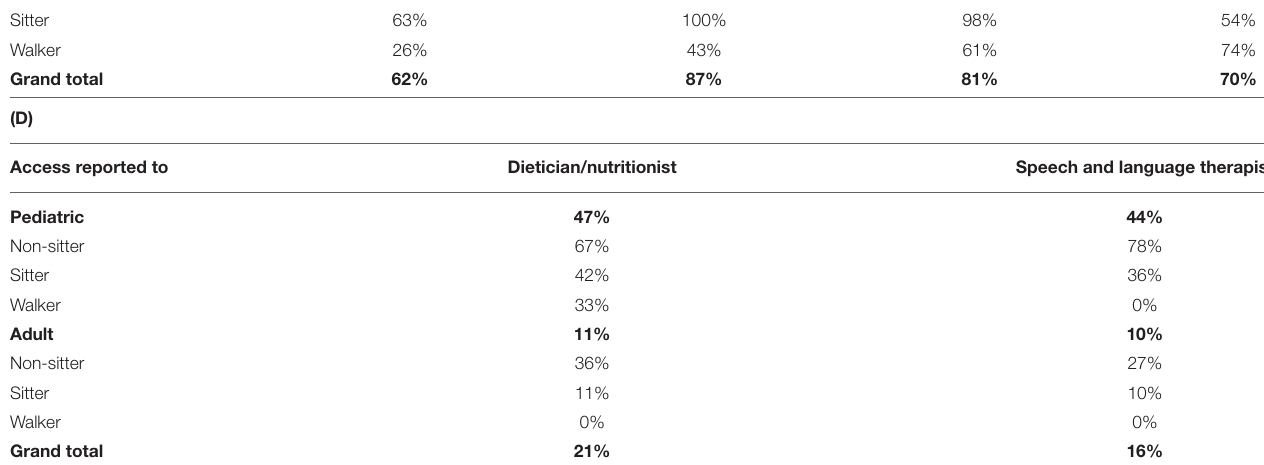
Access reported to Occupational therapist Mobility aids Home adaptations Exercise